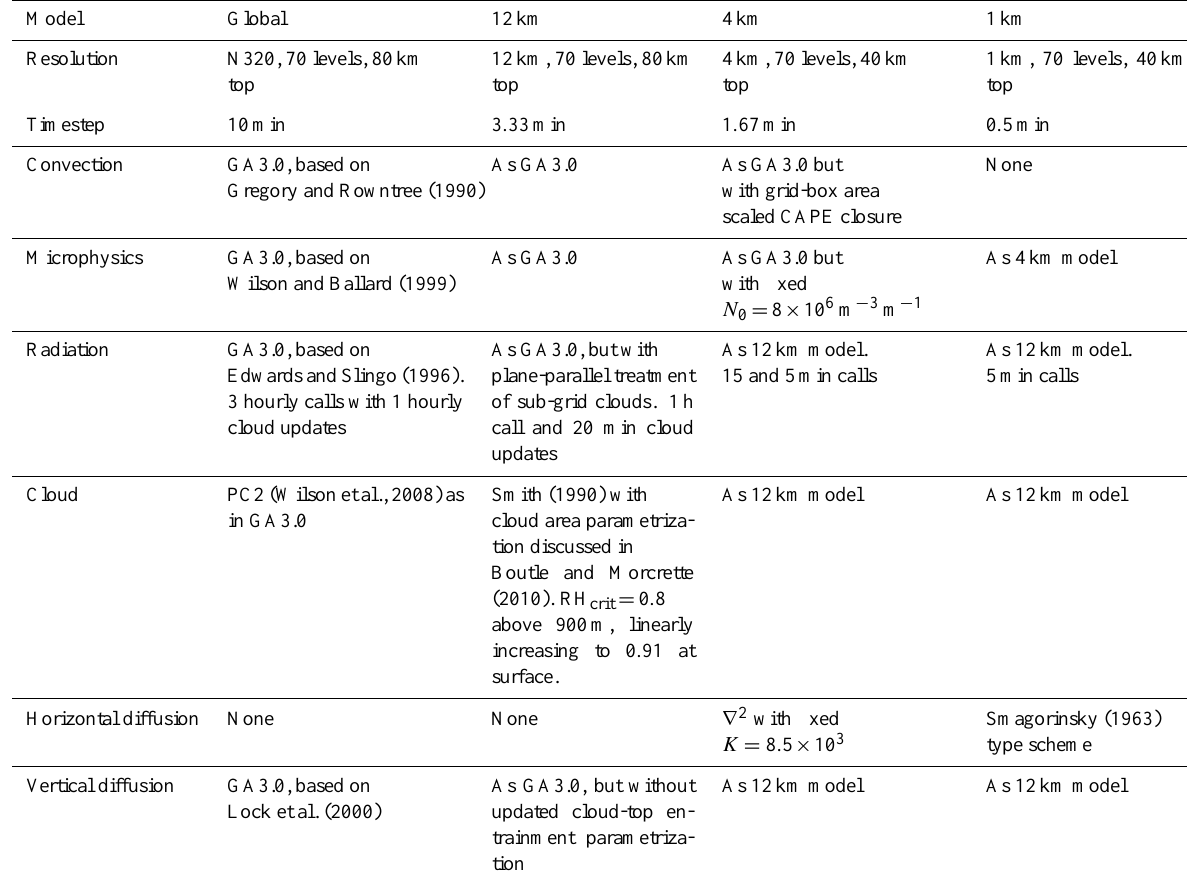
Table 1. Table showing the differences between different resolution models. Model